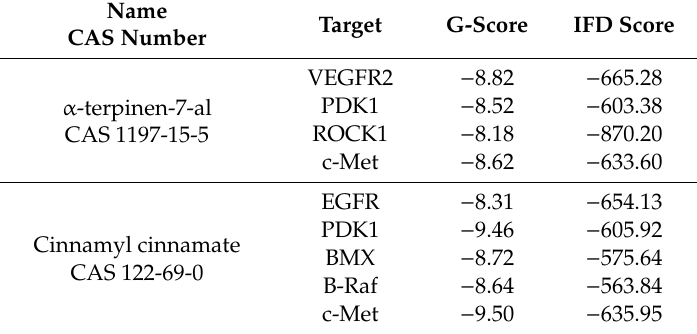
Table 2. G-score and Induced Fit Docking (IFD) scores, expressed in kcal / mol, of α -terpinen-7-al and cinnamyl cinnamate complexed with kinase proteins selected by SBVS. Name Target G-Score IFD Score CAS Number α